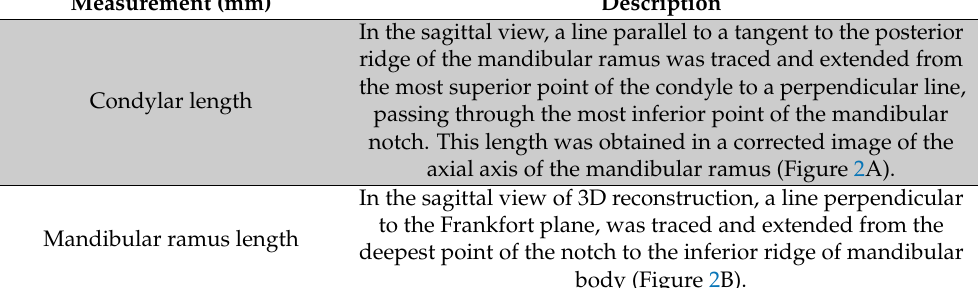
Table 1. Description of craniofacial measurements taken in the 3D bone tissue reconstruction,